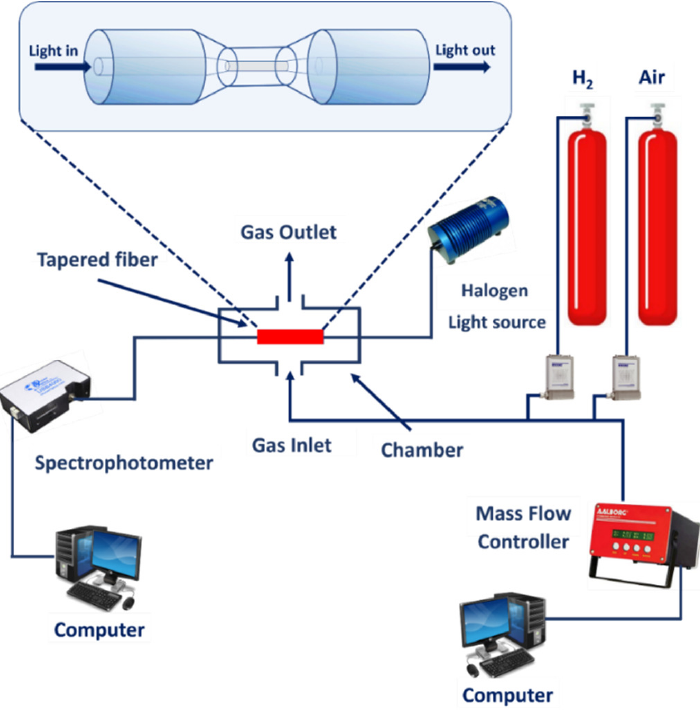
Figure 6. Absorbance measurement gas testing setup.